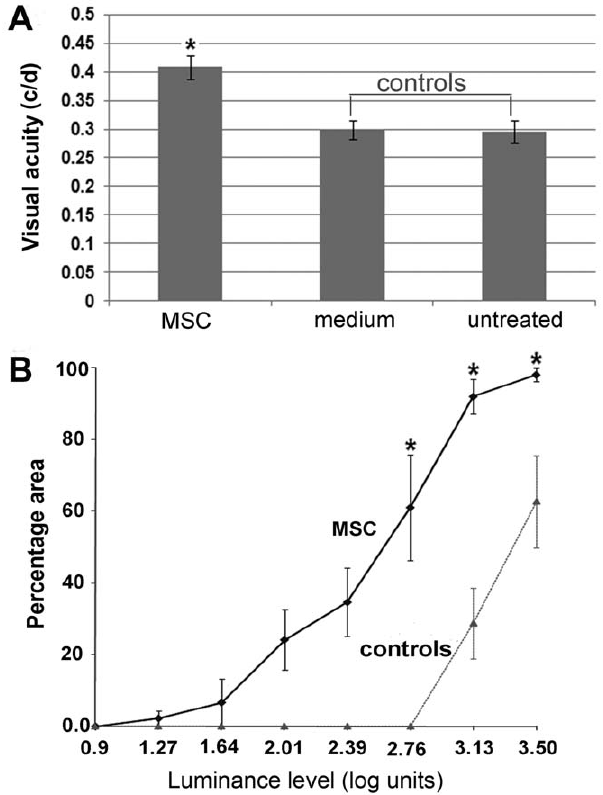
Figure 2. Preservation of visual function. A. Visual acuity tested by Optomotor response. Unrestrained animals were placed on a platform, where they tracked the grating with reflexive head movements. The acuity threshold was quantified by increasing the spatial frequency of the grating. RCS rats received MSCs and medium injection via tail vein at P30 and tested at P90. Visual acuity was significantly better in MSC treated eyes compared with controls (P , 0.001). A value of 0.43 c/d was recorded, which was 78% of normal value (0.55 c/d in wild-type). B. The luminance threshold was evaluated by recording single and multiunit activity close to the surface of the superior colliculus (SC). It measures functional sensitivity across the visual field, which in turn provides a topographic indication of the magnitude and area of photoreceptor rescue across the retina. MSC treated rats recorded around P90–100 revealed significantly lower threshold than controls (P , 0.005), for example, over 60% of the SC area had threshold at 2.76 log units in MSC treated eyes, no detectable response in control